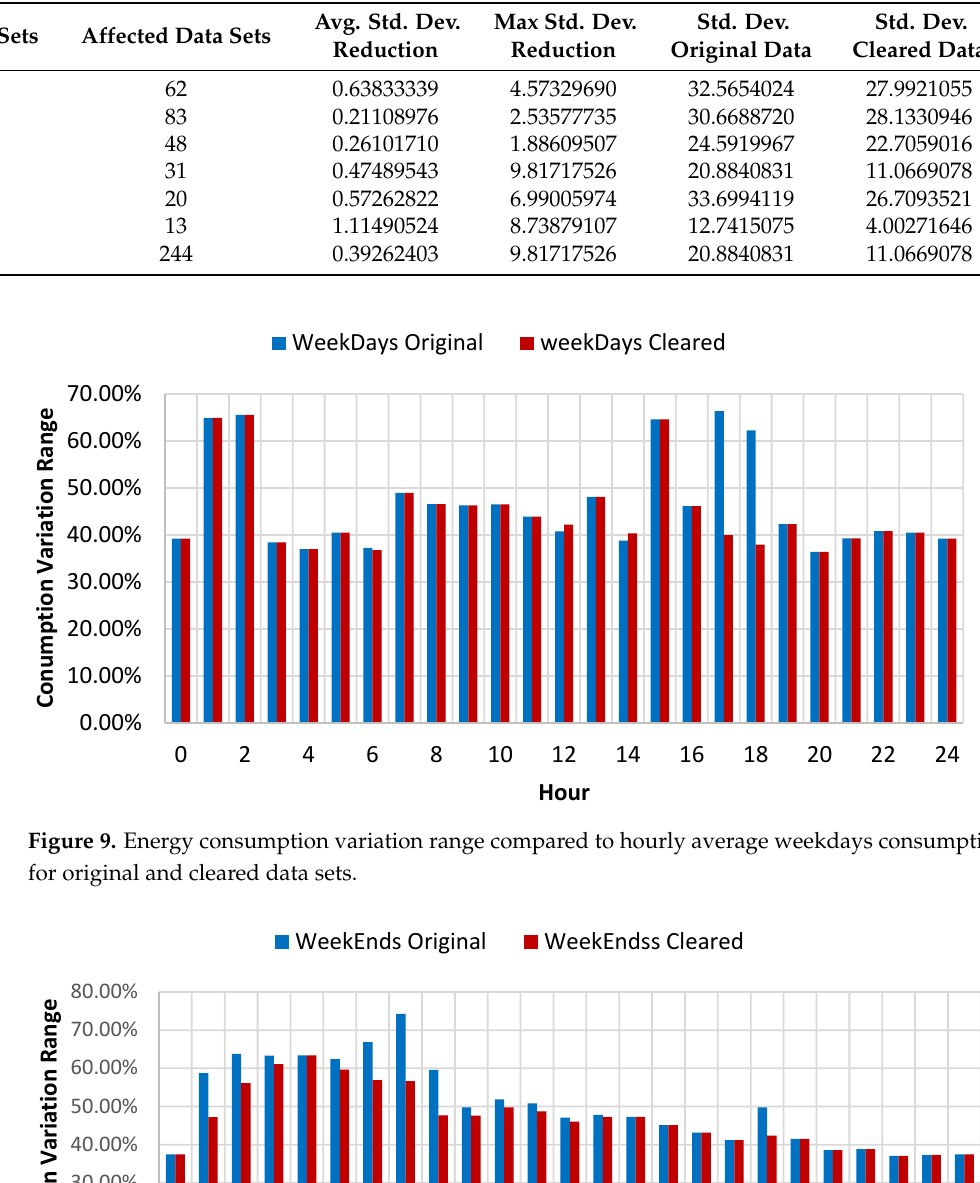
Table 6. Full year baseline for original and cleared data.